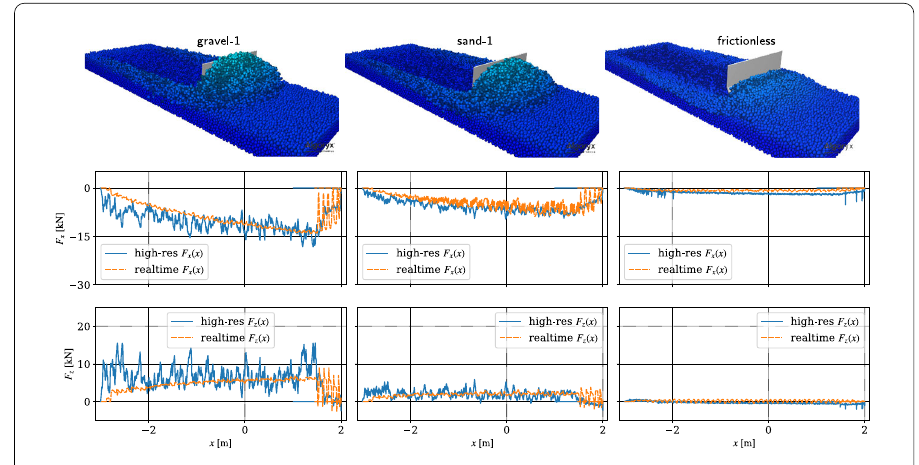
Fig. 9 Force resistance from bulldozing using three frictional soils and the microscale model, with snapshot taken at 8 s